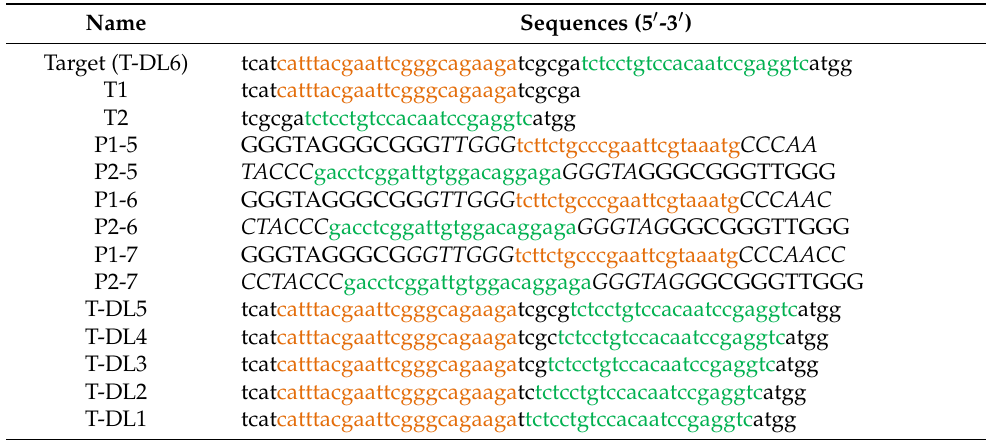
Table 1. The sequences of the ODNs used in this